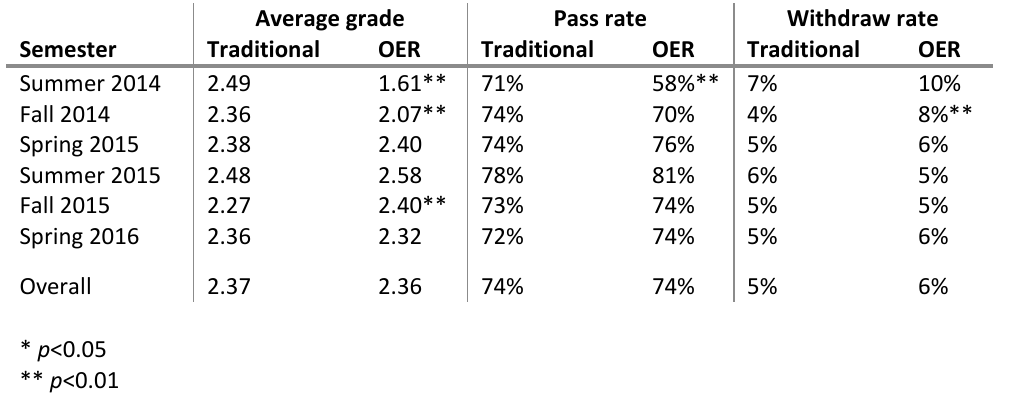
Figure 8. Average grade, Pass, and Withdraw rates for traditional and OER courses, Summer 2014-Spring